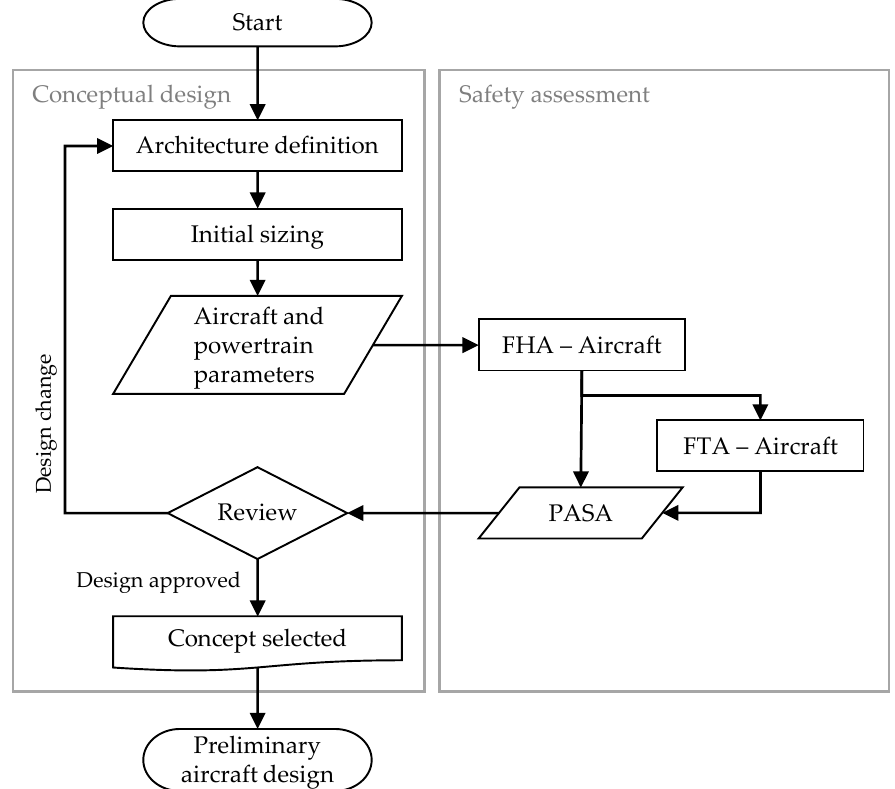
Figure 7. General process of the integrated safety assessment within the initial sizing